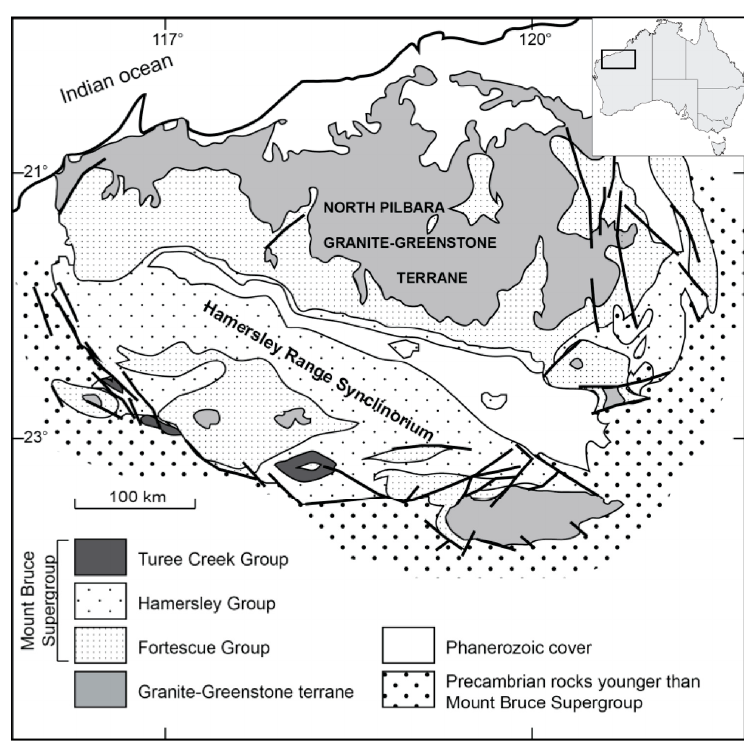
Figure 1. Geological overview of the Pilbara region in Western Australia. The economically valuable banded-iron formations are hosted mainly by the Hamersley Group of the Mount Bruce Supergroup (after [17]).